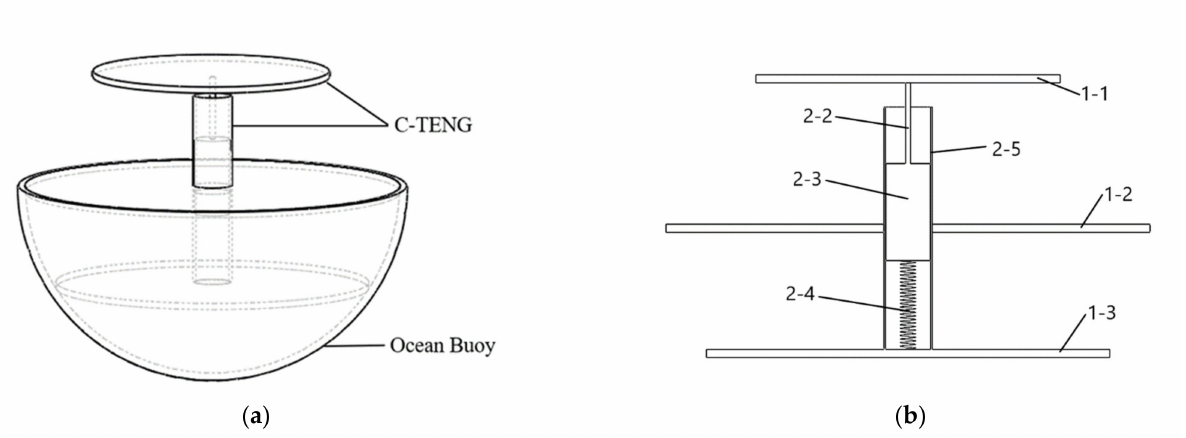
Figure 2. Model of C-TENG. ( a ) model of the assembly; ( b ) cutaway view of